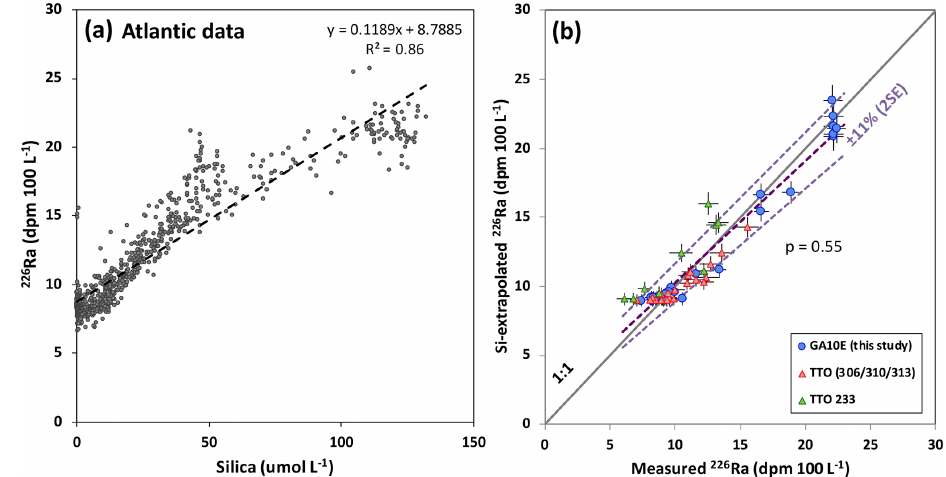
Figure A1. (a) Relationship between the Atlantic seawater 226 Ra activity and silica concentration (GEOTRACES GA03, GEOSECS, and TTO datasets; Ku and Lin, 1976; Key et al., 1990, 1992a, b; Charette et al., 2015). The dashed line shows a linear regression through all the data. (b) Plots of Si-extrapolated 226 Ra against measured 226 Ra in this study and the TTO programme. The paired t test shows a p value of 0.55 ( > 0 . 05). The solid line is 1:1, and the dashed purple lines show the linear regressions with the error bars of ± 11% (2 SE).